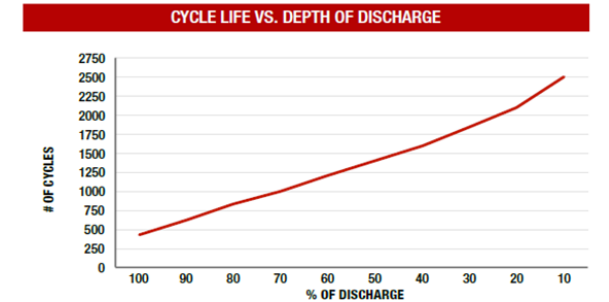
Figure 18. Surette S 460 cell cycling capacity and the DoD [89].